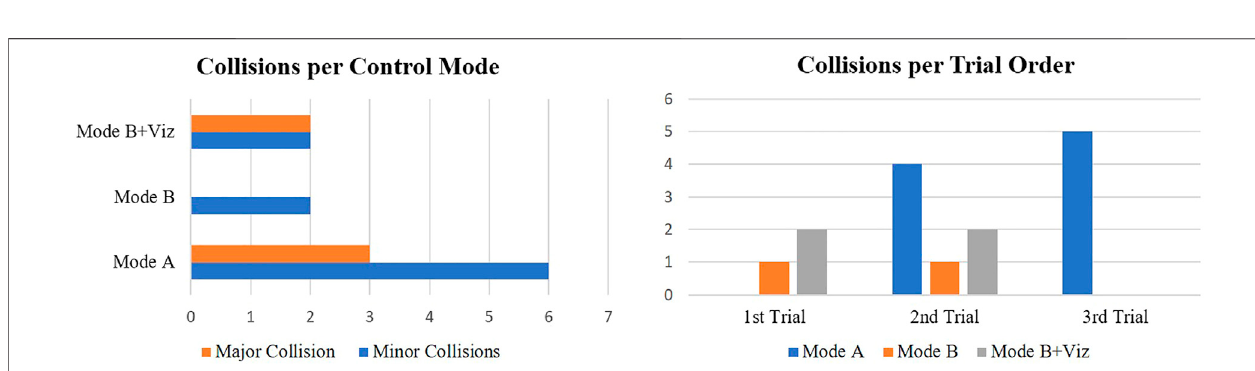
FIGURE8| Numberofcollisionsforthethreecontrolmodesillustratedasafunctionofcollisiontypeandtrialorder.Directteleoperationhadamuchhighercollision frequency over shared control modes ( “ B ” and “ B + Viz ” ), despite only occupying a single run per subject. Any potential improvements derived from users learning the task across multiple trials also had no positive impact on the collision count for mode “ A ” .